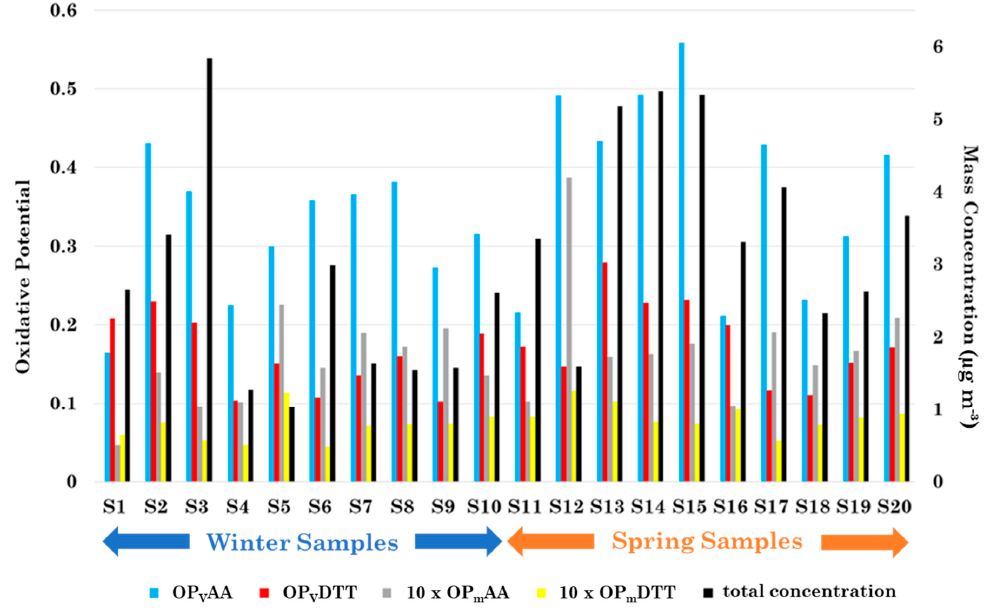
Figure 2. Temporal evolution of volume-normalized ascorbic acid- and dithiothreitol-oxidative potential (OP V AA and OP V DTT, respectively, expressed in nmol min − 1 m − 3 ), mass-normalized ascorbic acid- and dithiothreitol-oxidative potential (OP m AA and OP m DTT, respectively, expressed in nmol min − 1 µg − 1 ), and the total mass concentration of all the analyzed chemical elements. OP m AA and OP m DTT values were multiplied by 10 to better visualize data. Table 2. Mean values and standard deviations (SD) of PM10 volume- and mass-normalized oxidative potential responses (OP V and OP m , respectively) obtained from ascorbic acid (AA) and dithiothreitol (DTT) assays and total mass concentration of all the analyzed metals (Al, As, Ba, Ca, Cd, Cr, Cu, Fe, K, Mn, Mo, Ni, Pb, Rb, Si, Sr, Ti, V, Zn, and Zr) and Br, P, S, and Se. The data related to the total analyzed period, the 10 winter samples (from January to March 2018), and the 10 spring samples (from May to June 2018) are reported. Values with a significant seasonal di ff erence (with p -value < 0.10) are marked in